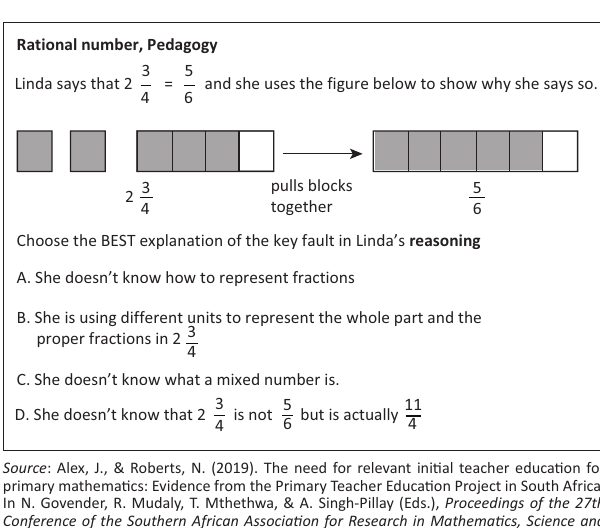
FIGURE 1: Exemplar items for lower and higher cognitive demand.